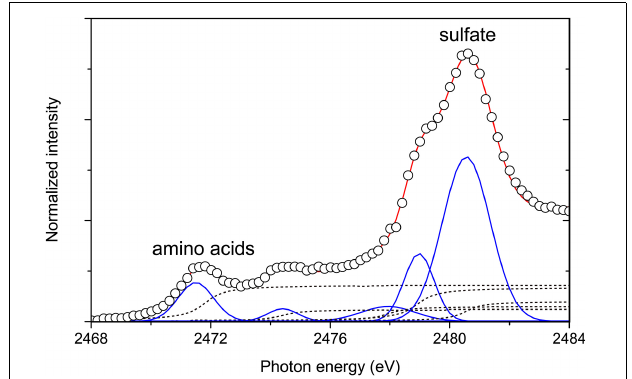
FIGURE 4 | Peak deconvolution of the near-edge region of the sulfur XANES spectrum obtained at the measurement point-8 of Figure 3 . The open circles and red line represent measured data and the best-fit line. The blue and dashed lines represent fitted Gaussian peaks and arctangent functions that represent the transition of ejected photoelectrons,